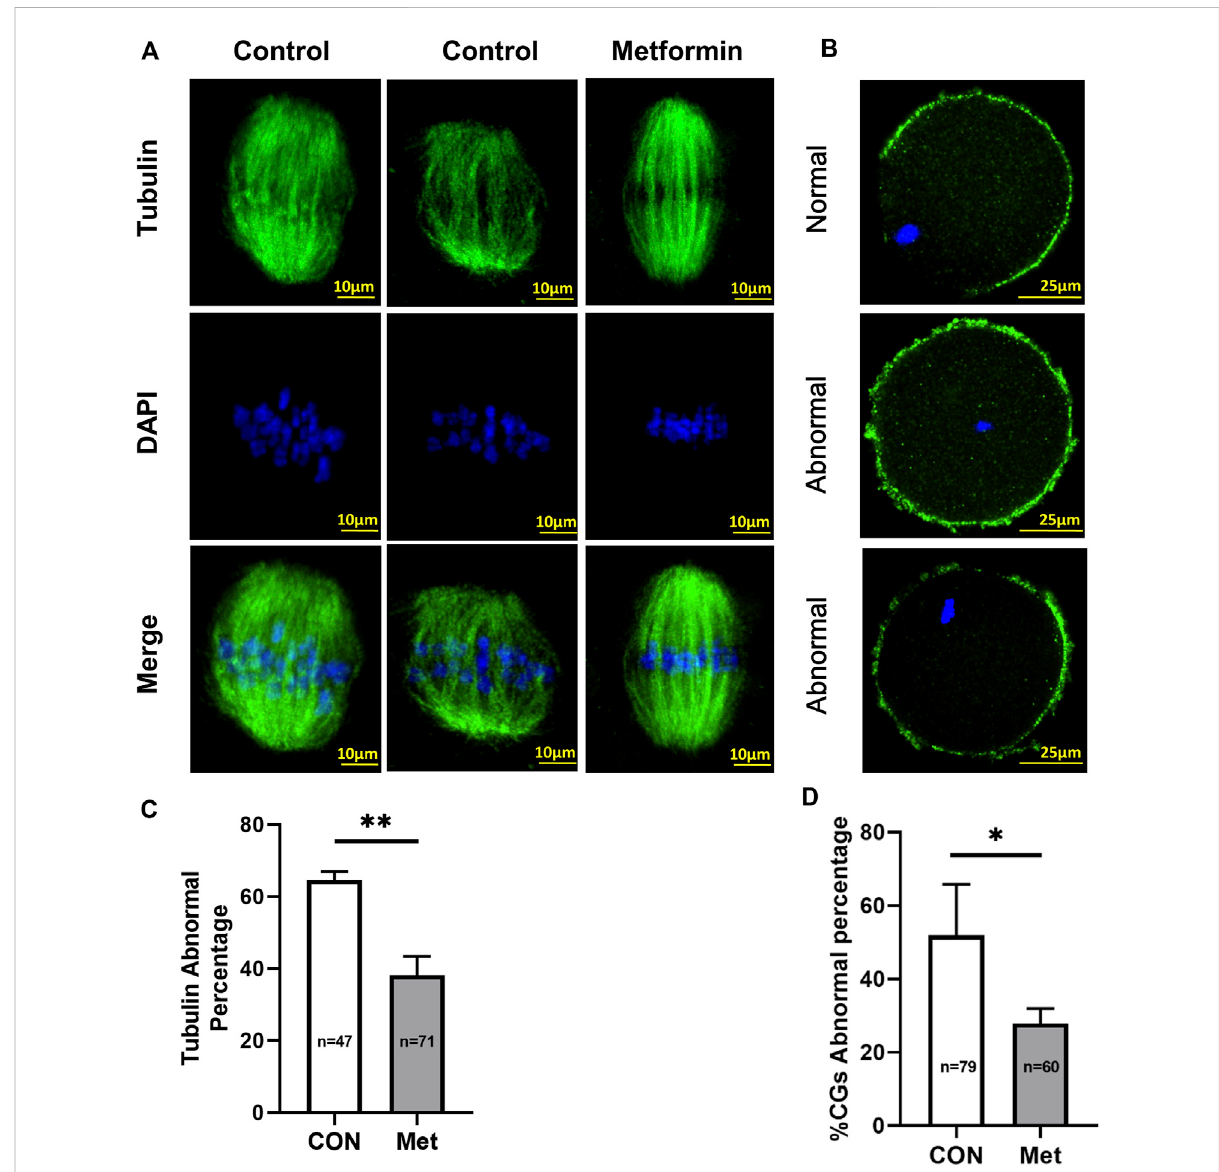
FIGURE 2 Metformin alleviates the meiotic defects of oocytes from aged mice and maintains a normal distribution of cortical granules (CGs). (A) Representative images of spindle/chromosome organization in M Ⅱ stage oocytes after in vitro maturation (IVM) oocytes from aged (7 – 9 month old) micein thecontrol andmetformin-treatmentgroups.Spindles werestained withan α -tubulinantibody (green); chromosomeswerecounterstained withDAPI(blue).Scalebar, 10 μ m. (B) Distinctdistributionsofcorticalgranules (CGs) incontrol vs.metformin-treated oocytesfrom agedmice. CGs in oocytes were stained with lens culinaris (LCA)-FITC ( fl uorescein isothiocyanate) (green); and chromosomes were counterstained with DAPI (blue). Scale bar, 25 μ m. (C) Quanti fi cation of abnormal spindle/chromosomes oocytes from aged mice in the control ( n = 47) and metformin- treatment group ( n = 71). (D) The proportion of oocytes with abnormallydistributedCGs with ( n =60)or without ( n = 79) metformin treatment.Data are means ± SD of at least three independent experiments. Means ± SD, * p < 0.05, ** p < 0.01 vs. control as calculated by two-tailed unpaired Student ’ s t-tests, the % data are subjected to by two-tailed unpaired Student ’ s t-tests after an arcsine-square-root